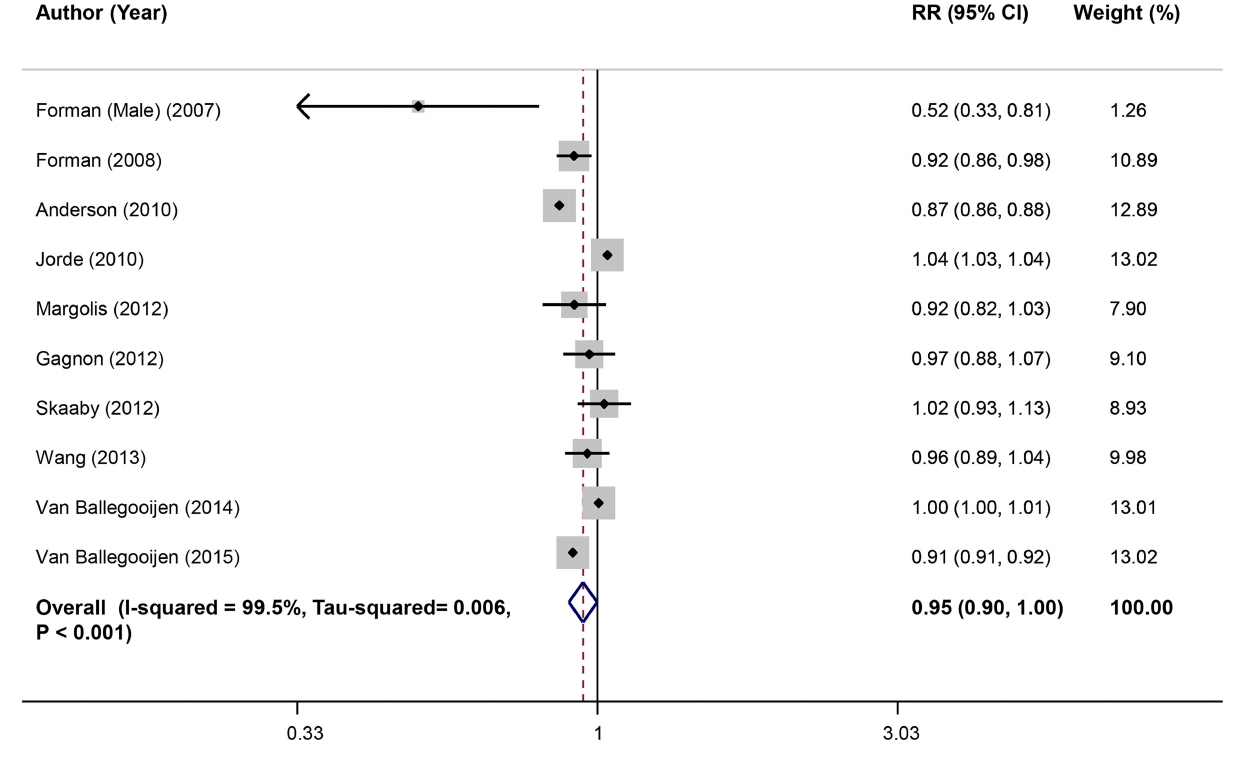
95% CI of overall effect contained a minimal value of 0.75; so, the certainty of the evidence was downgraded for